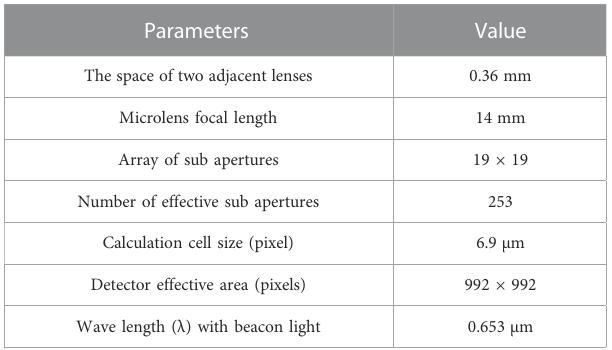
TABLE 1 Structure parameters of p-SHWFS used in